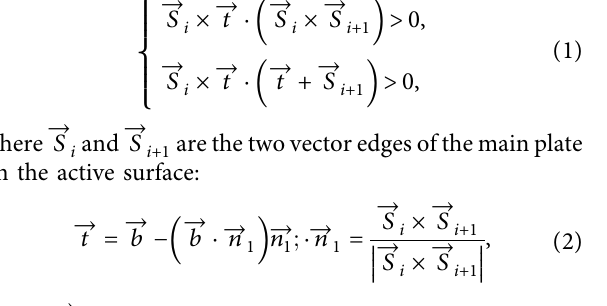
Figure 1: Contact between the driven node and the active surface.